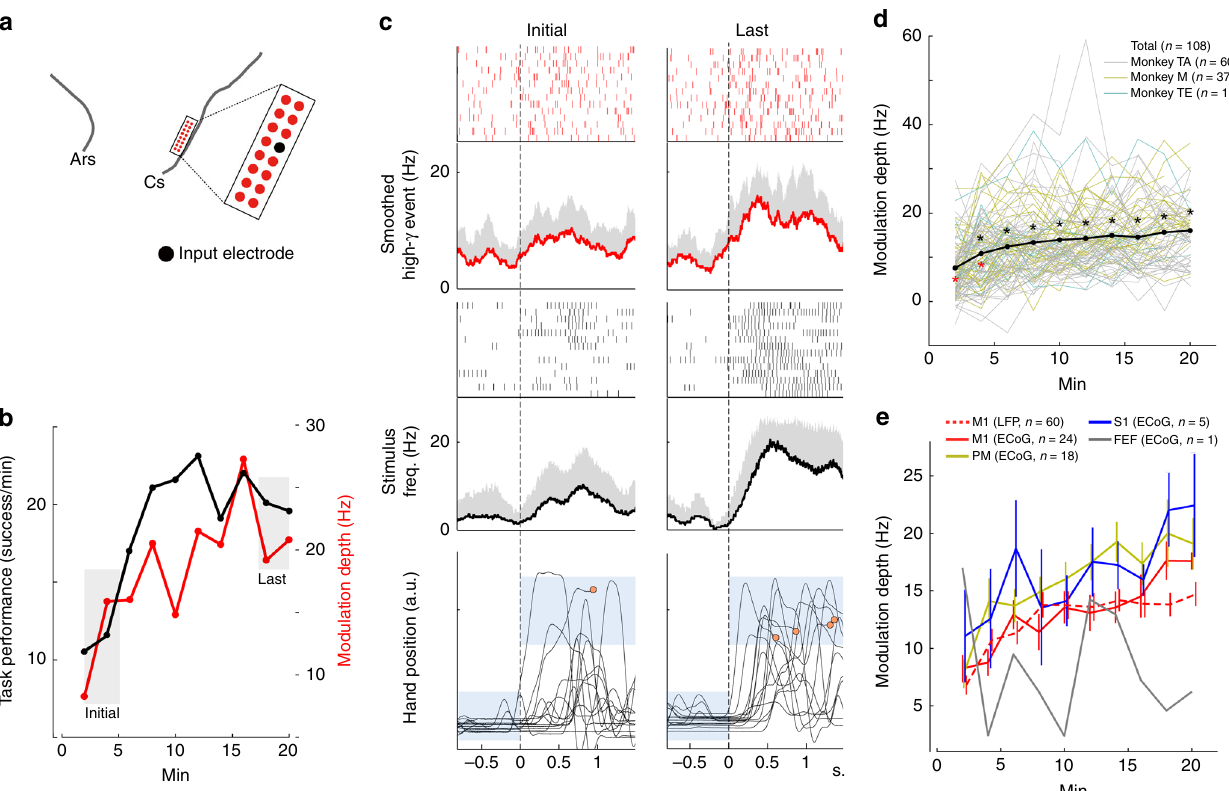
Fig. 3 Changes in the pattern of high-gamma signal input during learning with an ACMC. a – c High-gamma activity of LFPs recorded from a penetrating electrode to grade muscle stimulation delivered to the ECR and EDC muscle pair in Monkey TA. a The black circle indicates the input electrode. b Representative time course of task performance (black line) and modulation depth (MD) of high-gamma activity at the input electrode site (red line). c Ensemble average of the raster plots of high-gamma activity, electrical stimulation, and hand position during the initial and last 14 trials. Plots are aligned to the time of target appearance, indicated by the vertical dotted lines. From the top, raster plot and averaged rate of occurrence of high-gamma activity, stimulus frequency, and hand position. The blue-shaded rectangles in the bottom trace represent the hand position targets. The orange dots represent the timing of successful trial completion and reward. d Average MDs measured at input electrodes ( N = 3 monkeys, n = 108 sessions, consisting of 72 torque- matching and 36 position-matching task sessions; Monkey TA, n = 60 sessions; Monkey M, n = 37 sessions; Monkey TE, n = 11 sessions). Black dots indicate means; lines represent individual sessions. Black and red asterisks represent signi fi cant differences ( P < 0.05 by one-way ANOVA with Bonferroni ’ s correction for post hoc multiple comparisons) compared to the initial and last 2 min, respectively. e Average MDs when input electrode was in the FEF (grey line, n = 1 session in Monkey M), PM (yellow line, n = 18 sessions in Monkey TE and M), M1 with ECoG array (red solid line, n = 24 sessions in Monkey TE and M), M1 with microelectrode array (dashed red line, n = 60 sessions in Monkey TA), and S1 (blue line, n = 5 sessions in Monkey M). MDs at the PM ECoG and S1 ECoG were signi fi cantly higher than MDs at the M1 LFP and FEF ECoG ( P < 0.05 by two-way ANOVA with Bonferroni ’ s correction for post hoc multiple comparisons). Detailed statistical results for ( d ), ( e ) are shown in the source data. Data in ( e ) represent means